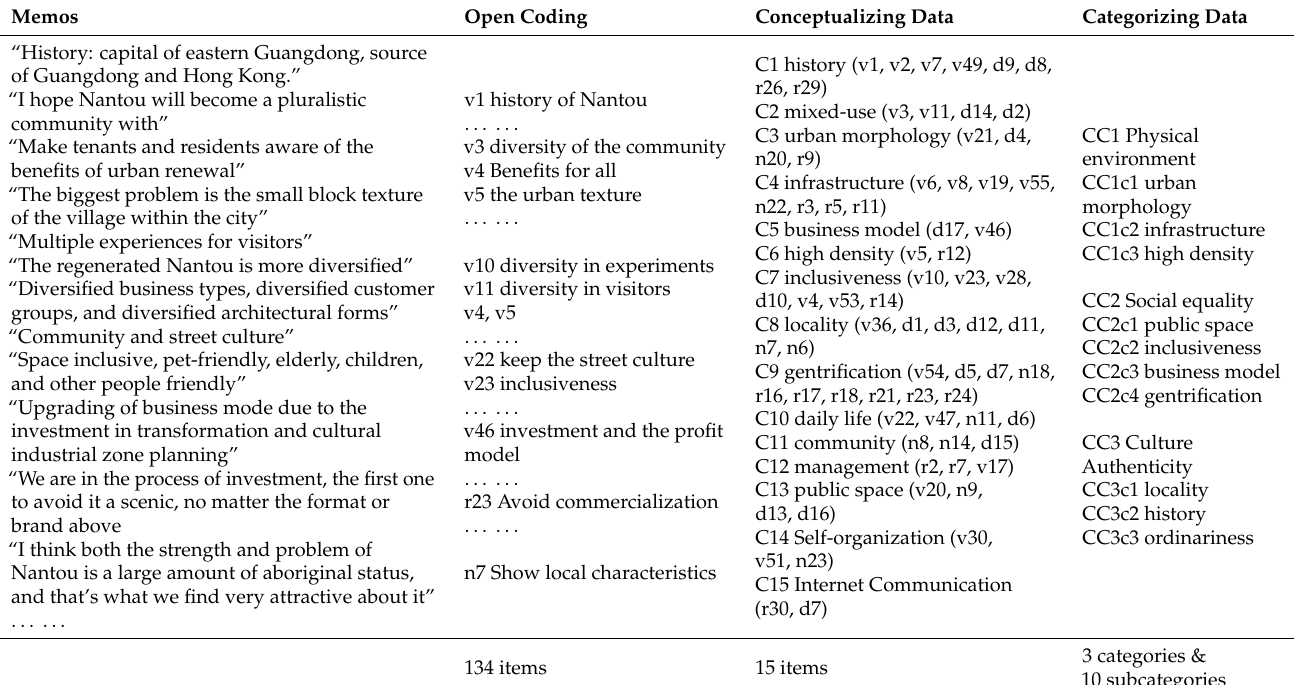
Table 2. Coding process for open coding, axial coding, and selective coding based on